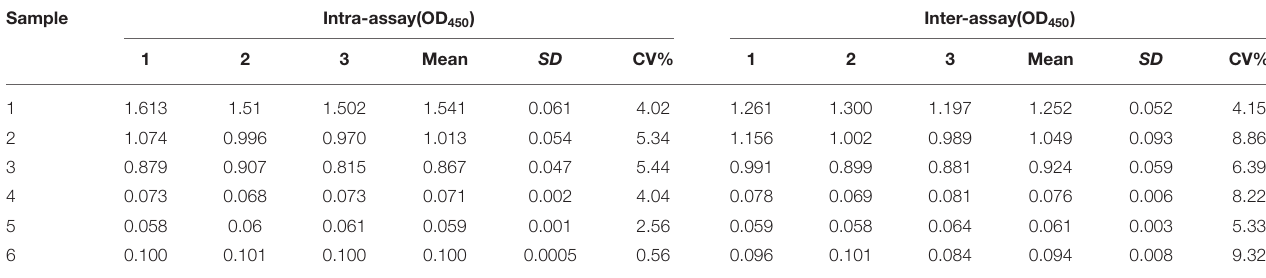
TABLE 3 | Repeatability and reproducibility analysis of indirect ELISA.